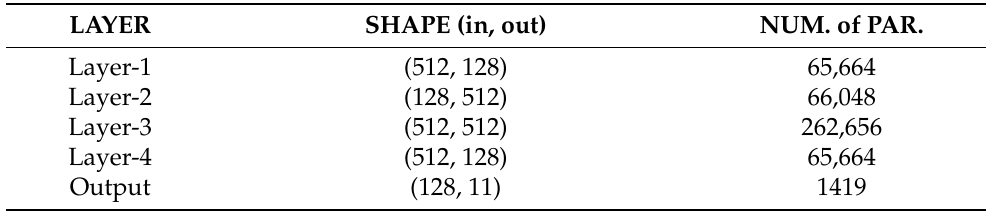
Table A1. Model Architecture for FOOD-11 classification used in the test for the dependence of model performance on data domain for different linearity factors ( α ). Categorical Cross-entropy loss was used for the loss estimation. Stochastic Gradient Descent (SGD) with learning rate = 0.1 was used as the